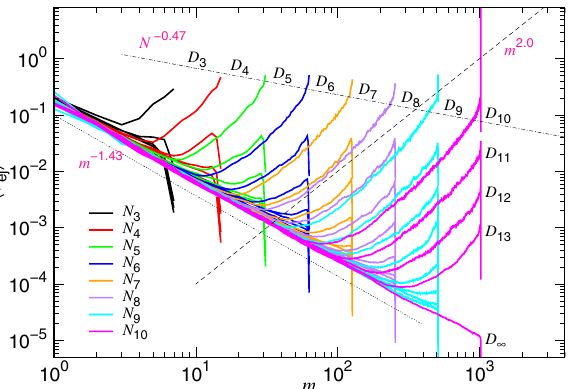
V ej Figure 3. Averaged ejection speed as a function of the number of monomers m in the cavity. The chain (cid:31) (cid:30) 2 i . The diameter D of cavity is indicated on the top-right length N is given in the legend by the formula N i = corner of the family curves which share the same D g value, calculated by using Eq. (7). The dashed line m 2.0 and the dotted line m − 1.43 show the scaling behavior of the ejection speed in the confined and the non-confined stages, respectively. The dash-dotted line N − 0.47 indicates the decreasing trend of the initial speed with the chain